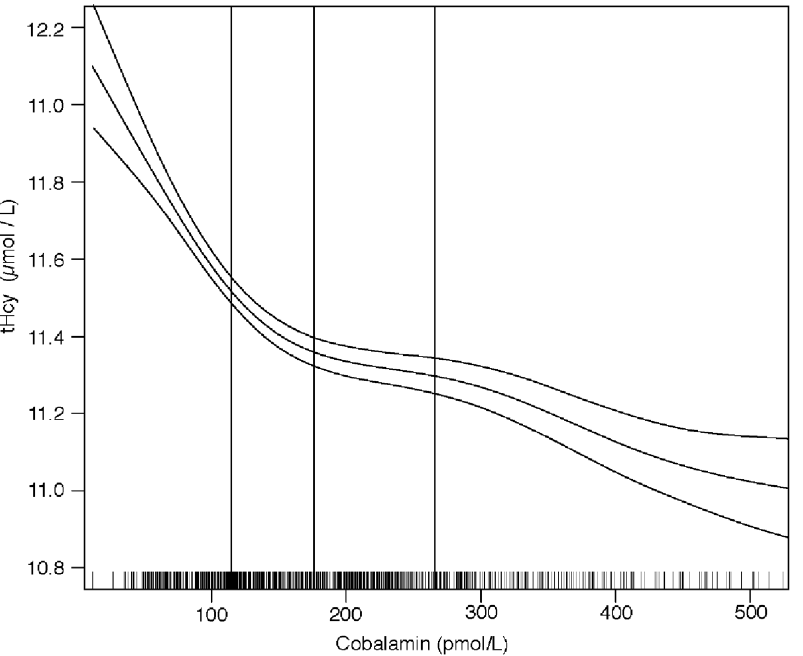
Figure 2. Association between plasma cobalamin and total homocysteine (tHcy) and methylmalonic acid (MMA) concentrations. The graphs were made by using generalized additive models in R. The upper and lower horizontal lines represent 95% CIs of regression line. The small bars on the x-axis show the distribution of individual observation and the vertical lines indicate the 25 th , 50 th and 75 th percentiles of the plasma cobalamin.